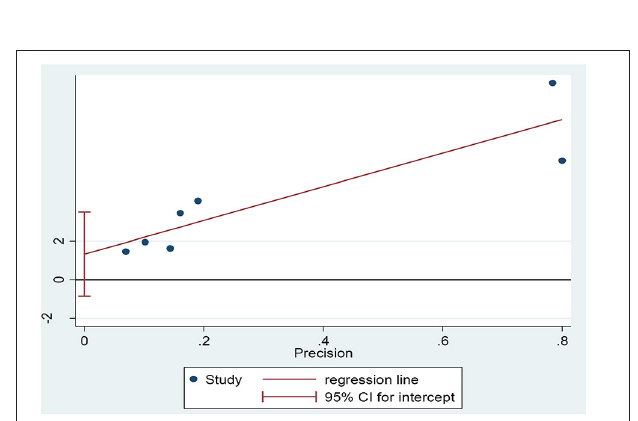
FIGURE 2 | The Forest plot of overall and individual prevalence of PTSD in the studies with 95% confidence interval.